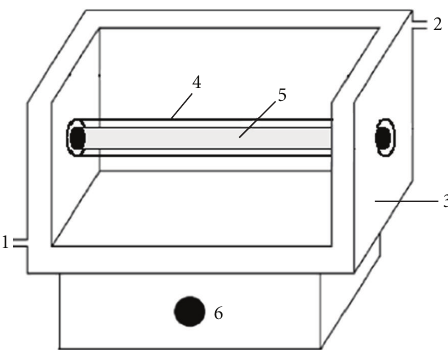
Figure 1: Schematic diagram of the photoreactor system. 1.Water entrance, 2.Water exit, 3.Glass jacket, 4.quartz cover, 5.UV lamp,